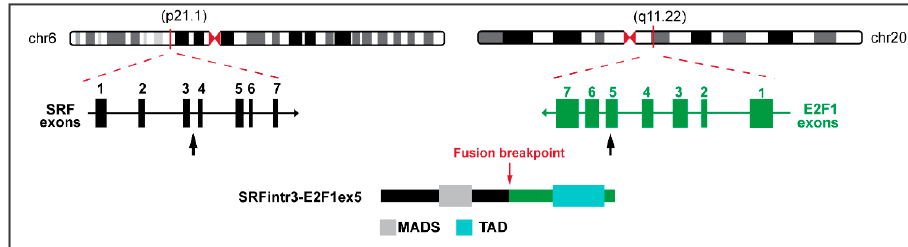
Figure 1. Schematic representation of SRF::E2F1 fusion transcript and predicted chimeric protein, depicting the exons and protein domains involved. The genomic exon structure of SRF and E2F1 are reported on the left and on the right, respectively. Black arrows indicate the breakpoint. The resulting chimeric protein is shown below [10]. MADS: MAD box DNA binding domain; TAD: Transactivation domain.